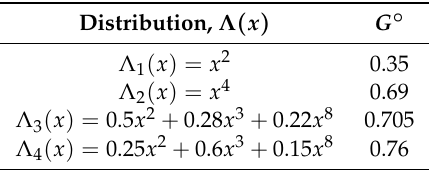
Table 1. Load threshold G ◦ for different probability distributions Λ ( x ) , for MAC frame length m = 200, = and packet loss rate target P ◦ L